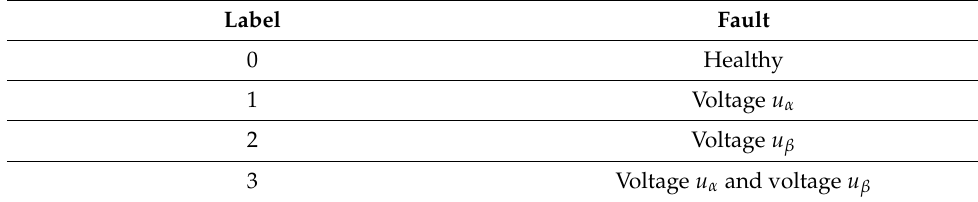
Table 2. Fault labels in actuator.